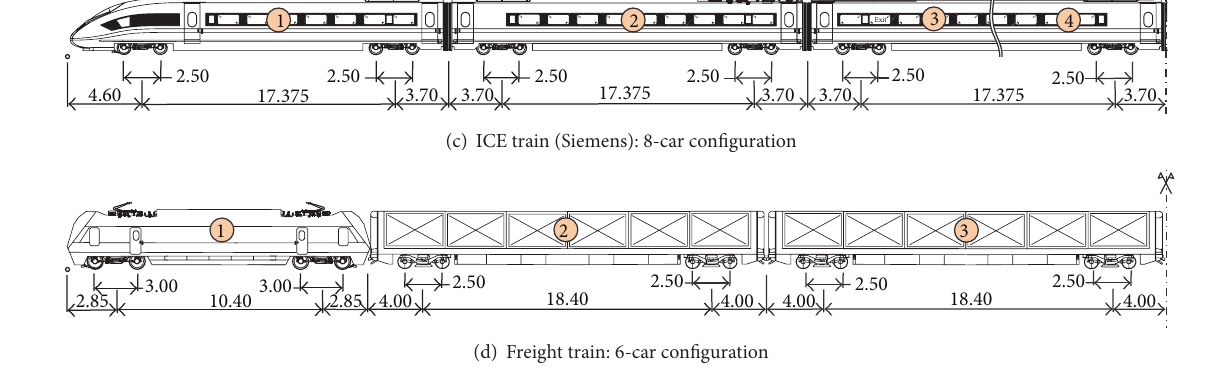
Figure 4: Geometrical configurations of the studied vehicles. Table 1: Dynamic parameters of the studied